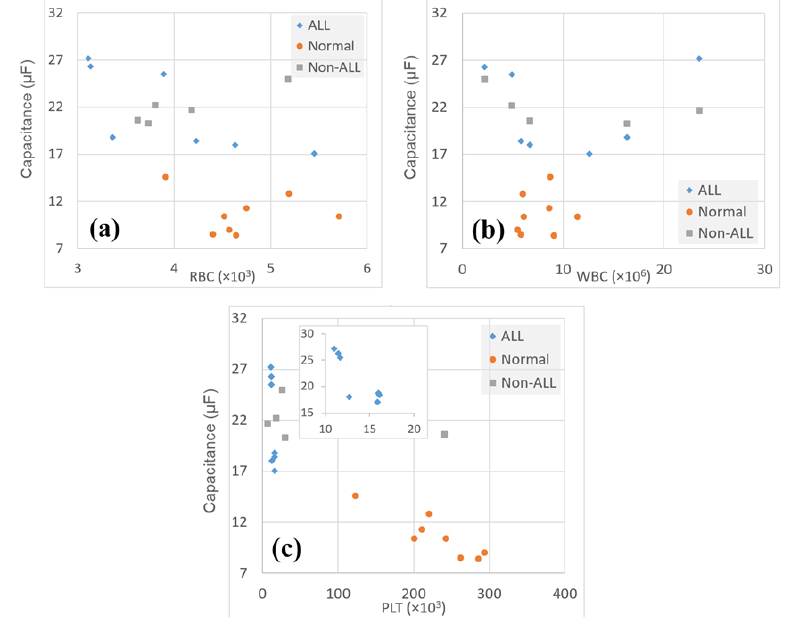
Figure 4. Diagrams of the three main blood factors of the examined samples, versus the measured capacitance. ( a ) White blood cells (WBCs). ( b ) Red blood cells (RBCs). ( c ) Platelets (PLTs). The inset